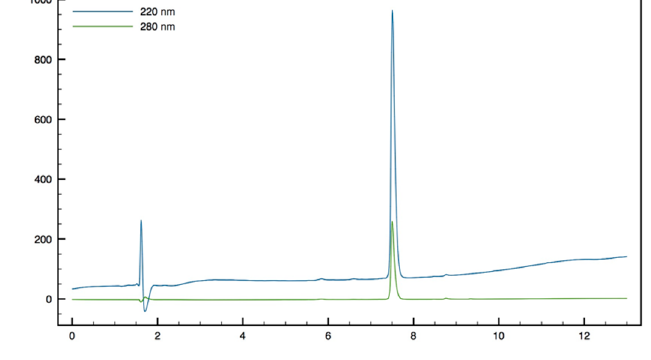
Figure 22. HPLC profile of H-Tbt - β 2,2 h bis-Arg-OBn 20 . Figure 22 . HPLC profile of H-Tbt- β 2,2 h bis-Arg-OBn 20 .